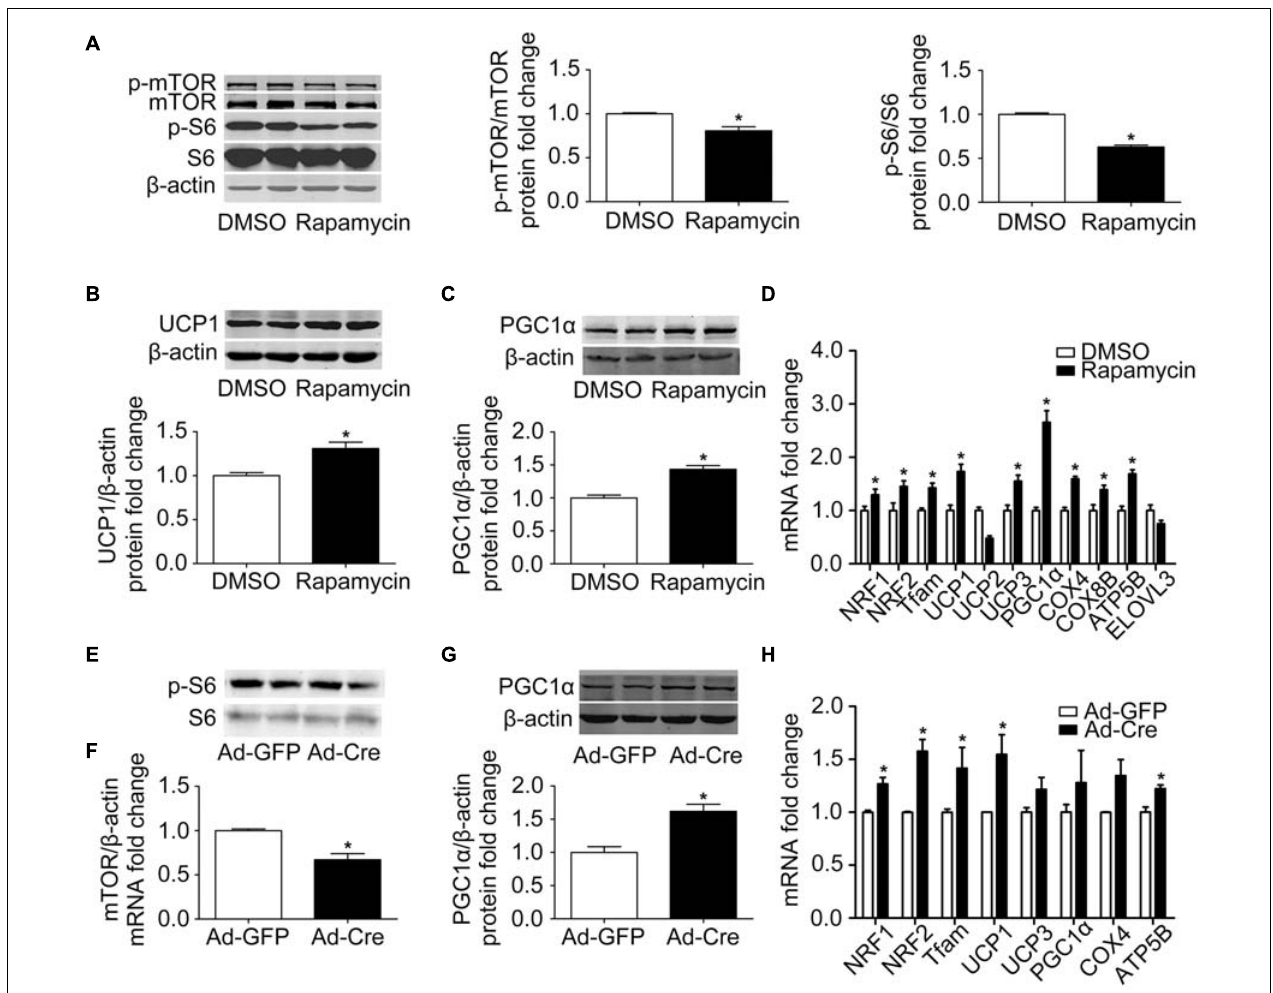
FIGURE 2 | Inhibition of mTOR promotes mitochondrial biogenesis of brown adipocytes. (A–C) Primary brown adipocytes were isolated from neonatal C57BL/6J mice and cultured for differentiation. Proteins were extracted after 6 days of differentiation. Western blotting of p-mTOR, p-S6, UCP1, and PGC1 α was performed with β -actin as a loading control. Relative protein signal intensity was quantified and expressed as means ± SD. (D) Total RNAs were extracted after 6 days of differentiation. Real-time PCR was performed to evaluate the expression of mitochondrial biogenesis marker genes with β -actin as the loading control, with results expressed as means ± SD. *Denotes P < 0.05 relative to control. (E,F) mTOR loxp / loxp brown adipocytes were treated with Cre adenoviruses for 48 h and controls with GFP adenoviruses. RNAs and protein were extracted as described in the methods section. Real-time PCR was performed to evaluate the expression of mTOR. Levels of mRNA expression were normalized to β -actin and expressed as means ± SD. (G) Representative results of western blot for PGC1 α with β -actin as the loading control. Relative protein signal intensity was quantified and expressed as means ± SD. (H) Real-time PCR was performed to evaluate the expression of genes related to mitochondrial biogenesis. Levels of mRNA expression were normalized to β -actin and expressed as means ± SD. * P < 0.05 vs.